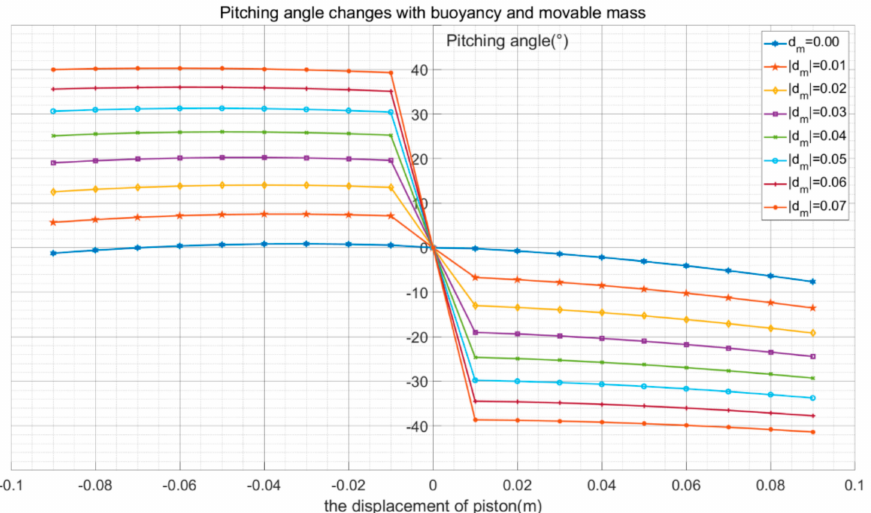
Figure 12. Change in pitching angle with buoyancy and movable